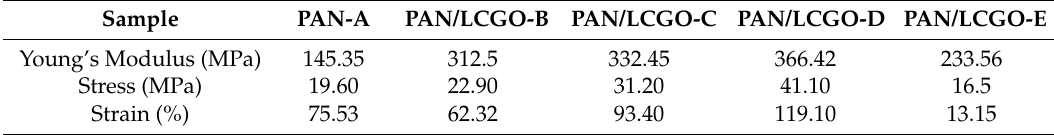
Table 3. Mechanical properties of PAN/LCGO nanofibrous twisted yarns at Yield